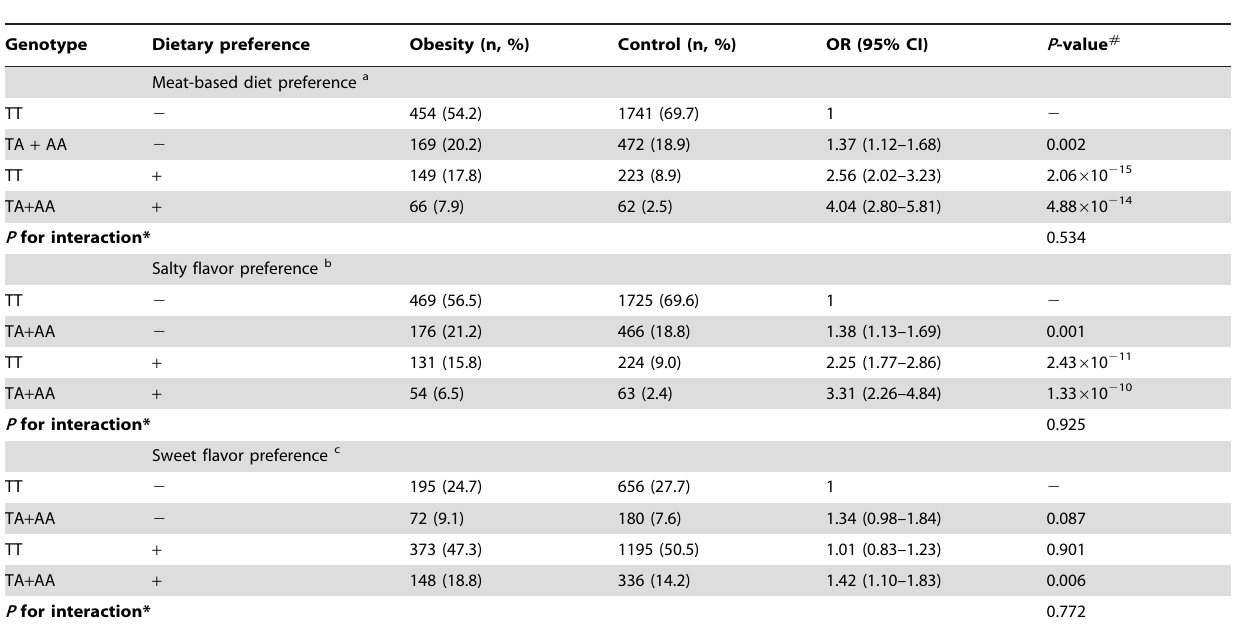
Table 5. Joint effects between the FTO rs9939609 genotypes, obesity, and dietary